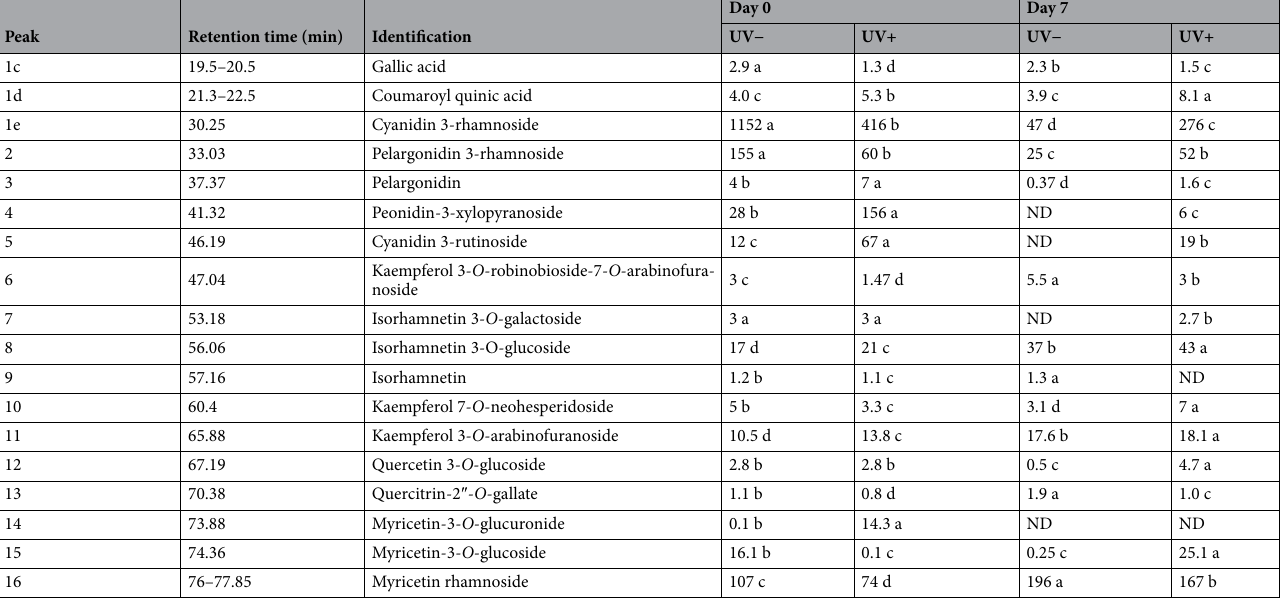
Table 1. Effect of UVC light treatments on the content of phenolic acids and flavonoids from acerola fruit determined by LC–MS. Values represent concentration (mg phenolics/100 freeze-dried acerola). Values represent the mean of three replicates. Values with different letters within the same compound represent statistical difference ( p < 0.05) by the Tukey’s HSD test. Concentration values for each type of compound were determined from chromatogram peak areas and standards (Table S1). Areas of peaks 1e to 5 were quantified at 520 nm (Fraction F4) and areas of peaks 1c, 1d, 6–16 were quantified at 330 nm (Fraction F3). ND not